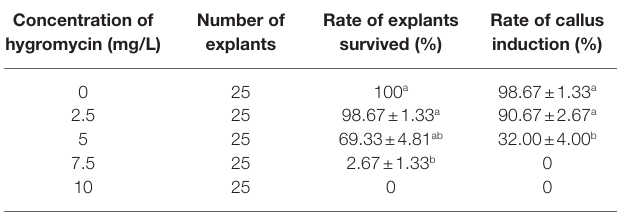
TABLE 1 | Details of sensitivity test for hygromycin on MS